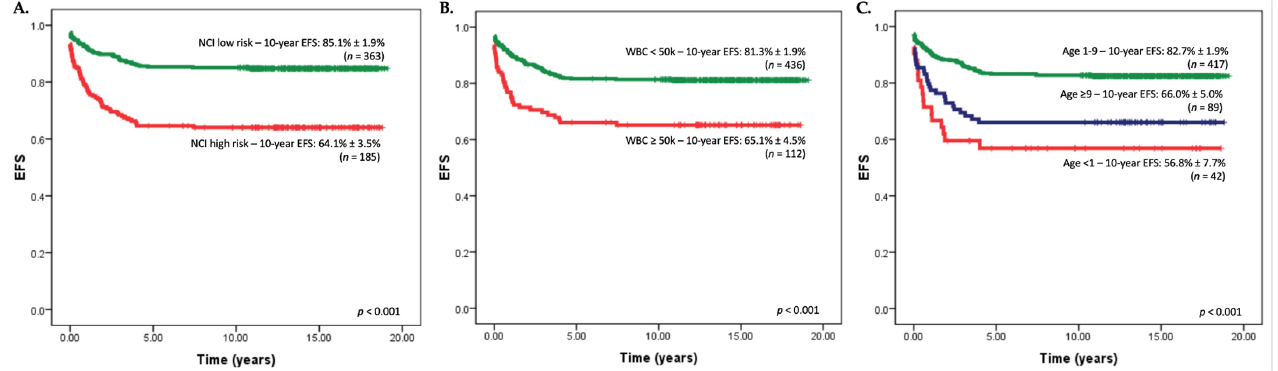
Figure 1. ( A – C ) Kaplan-Meier 10-year event-free-survival (EFS) curves from the Malaysia-Singapore ALL 2003 study cohort: significant differences in outcomes based on features from the National Cancer Institute (NCI) risk criteria such as total white blood cell (WBC) count at diagnosis and age were found; in this study risk stratification was based primarily on end-of-induction PCR-MRD responses. ( A ) 10-year EFS based on the presence of NCI low versus high-risk criteria, ( B ) 10-year EFS based on total white cell count at diagnosis, ( C ) 10-year EFS based on NCI criteria defined age groups. NCI risk criteria has been shown to clearly define groups of patients with clinically significant differences in long term EFS regardless of MRD response at the end of induction. This is a finding that is especially relevant to children in LMIC set- tings who may not have access to MRD monitoring and risk stratification during treatment. Children with lower risk ALL can already be defined early at the point of diagnosis based on NCI risk features.